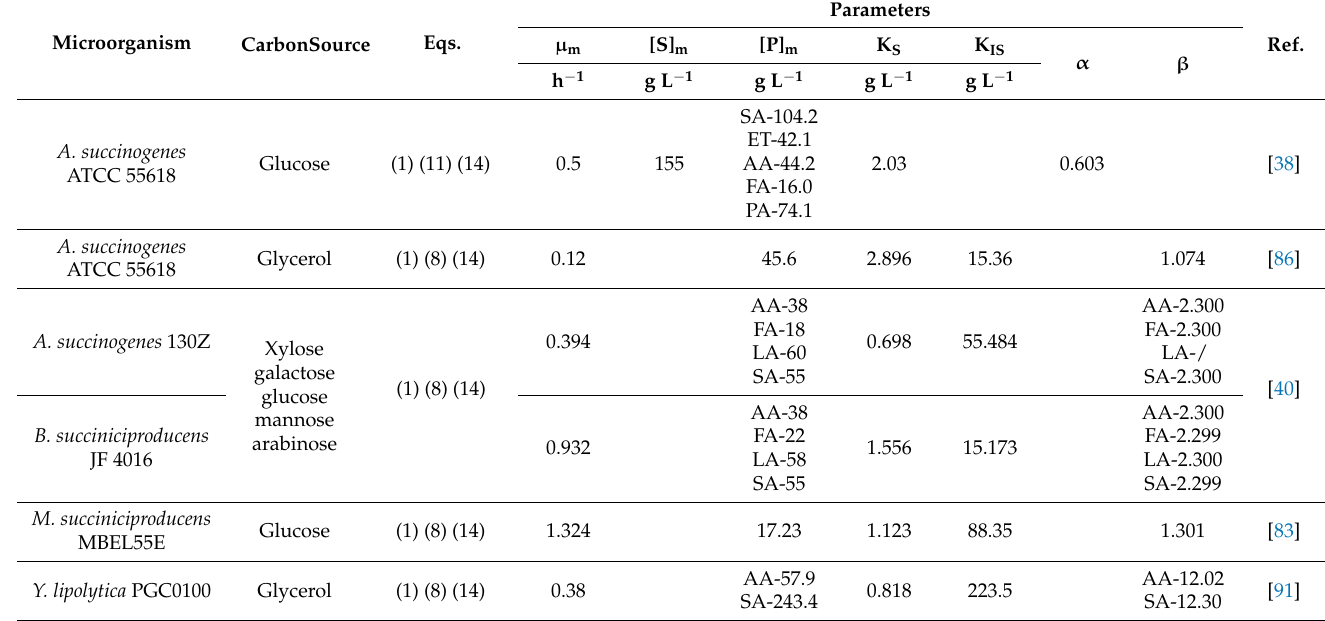
Table 2. Parameters from non-segregated unstructured biomass growth kinetic